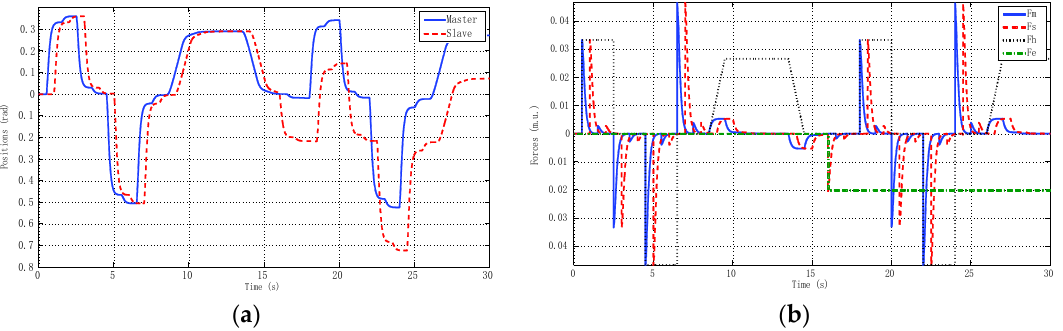
Figure 15. Local teleoperation using linear models of master and slave with h max = 0.5 s and d = 0.45. ( a ) Positions; ( b ) Forces.